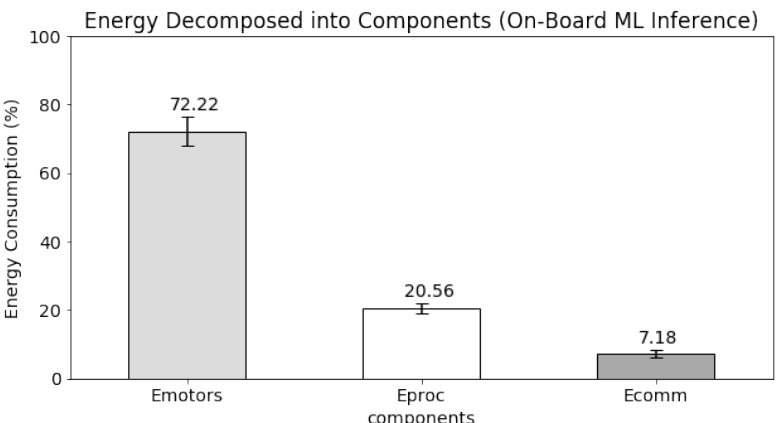
Figure 6. Energy decomposed into components (On-board ML with